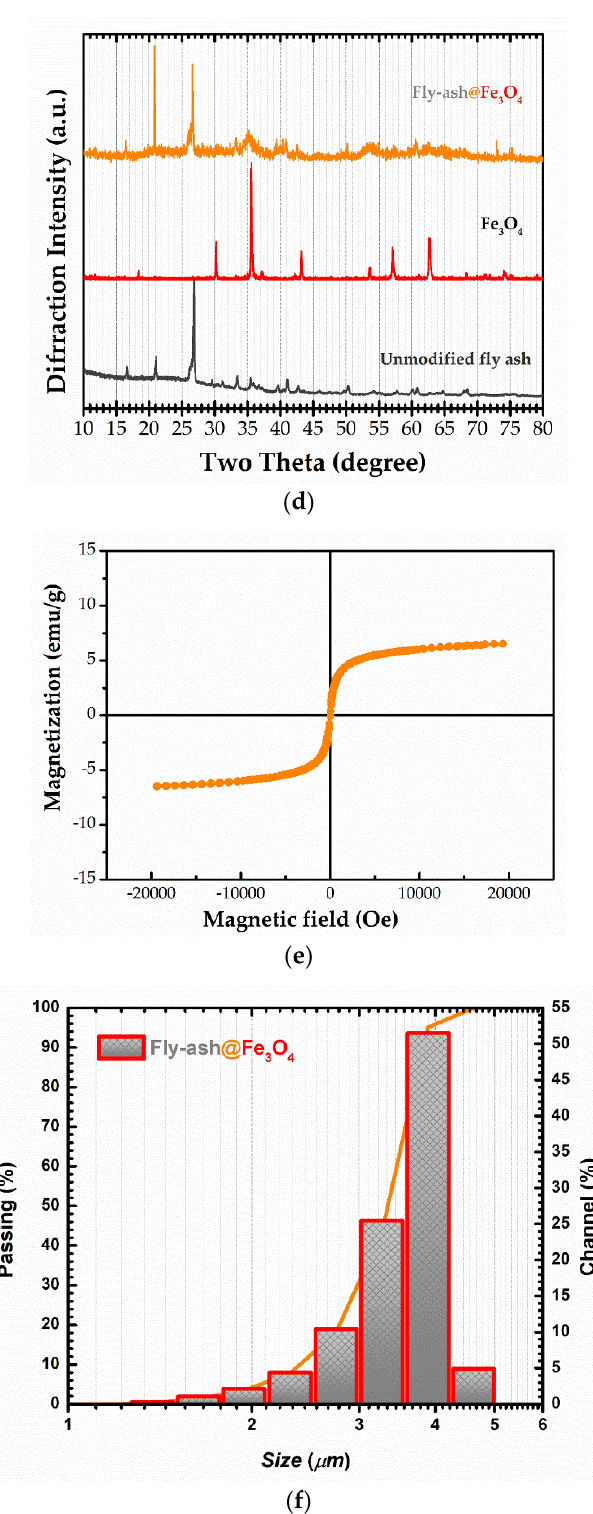
Figure 1. Characterization of unmodified fly ash and Fly-ash@Fe 3 O 4 materials:( a ) SEM images of unmodified fly ash at different magnifications; ( b ) SEM images of Fly-ash@Fe 3 O 4 material at different magnifications; ( c ) EDS spectrum of unmodified fly ash and Fly-ash@Fe 3 O 4 ; ( d ) XRD analysis of unmodified fly ash and Fly-ash@Fe 3 O 4 ; ( e ) VSM analysis of Fly-ash@Fe 3 O 4 ; ( f ) DLS analysis of Fly-ash@Fe 3 O 4 .